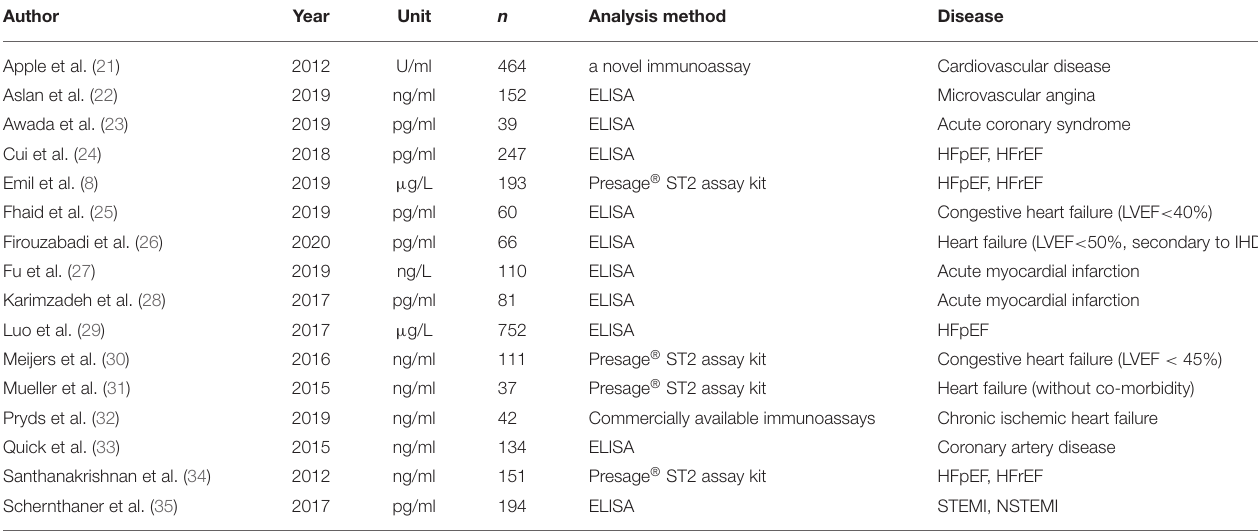
TABLE 1 | The characteristics of the included